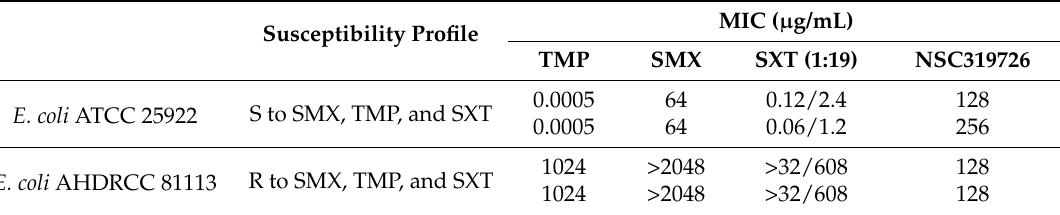
Table 3. Recorded MICs ( µ g/mL) for TMP, SMX, SXT, and NSC319726 against E. coli ATCC 25922 and E. coli AHDRCC 81113 ( n = 2).